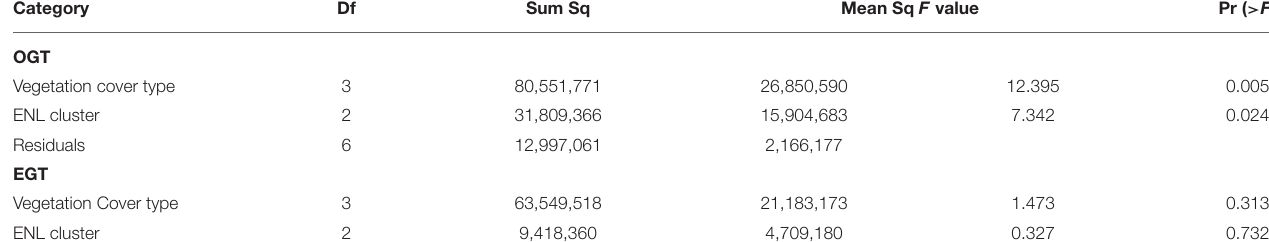
TABLE 6 | Generalized linear models for spatial coverage and early, normal, and late (ENL) cluster for OGT and EGT. Category Df Sum Sq Mean Sq F value Pr ( > F )